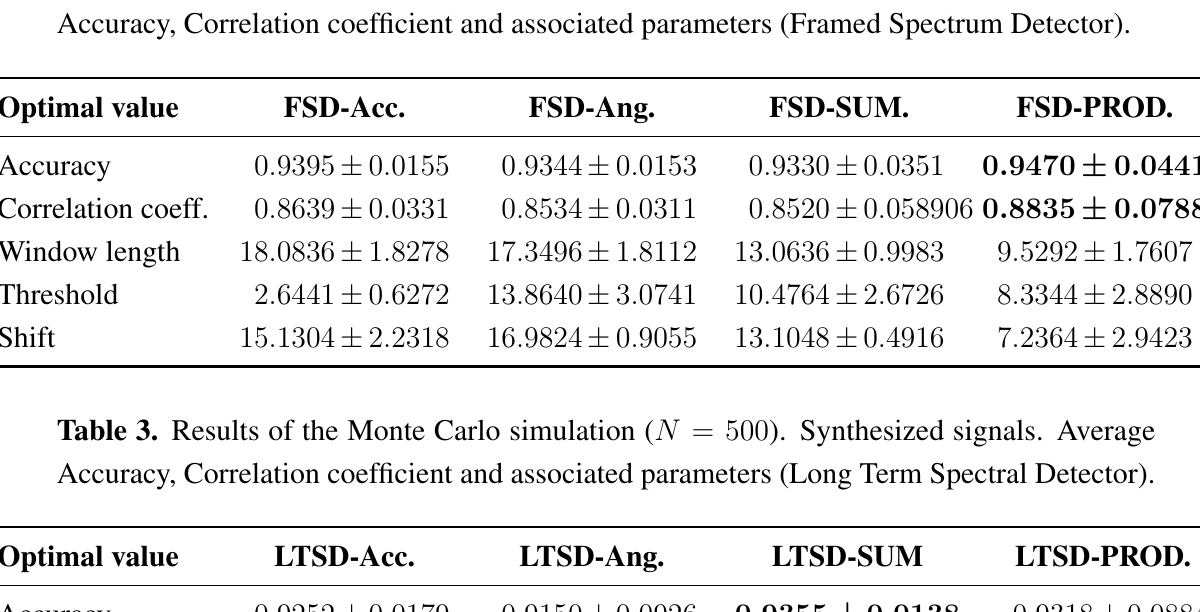
Table 2. Results of the Monte Carlo simulation ( N = 500 ). Synthesized signals. Average Accuracy, Correlation coefficient and associated parameters (Framed Spectrum Detector).